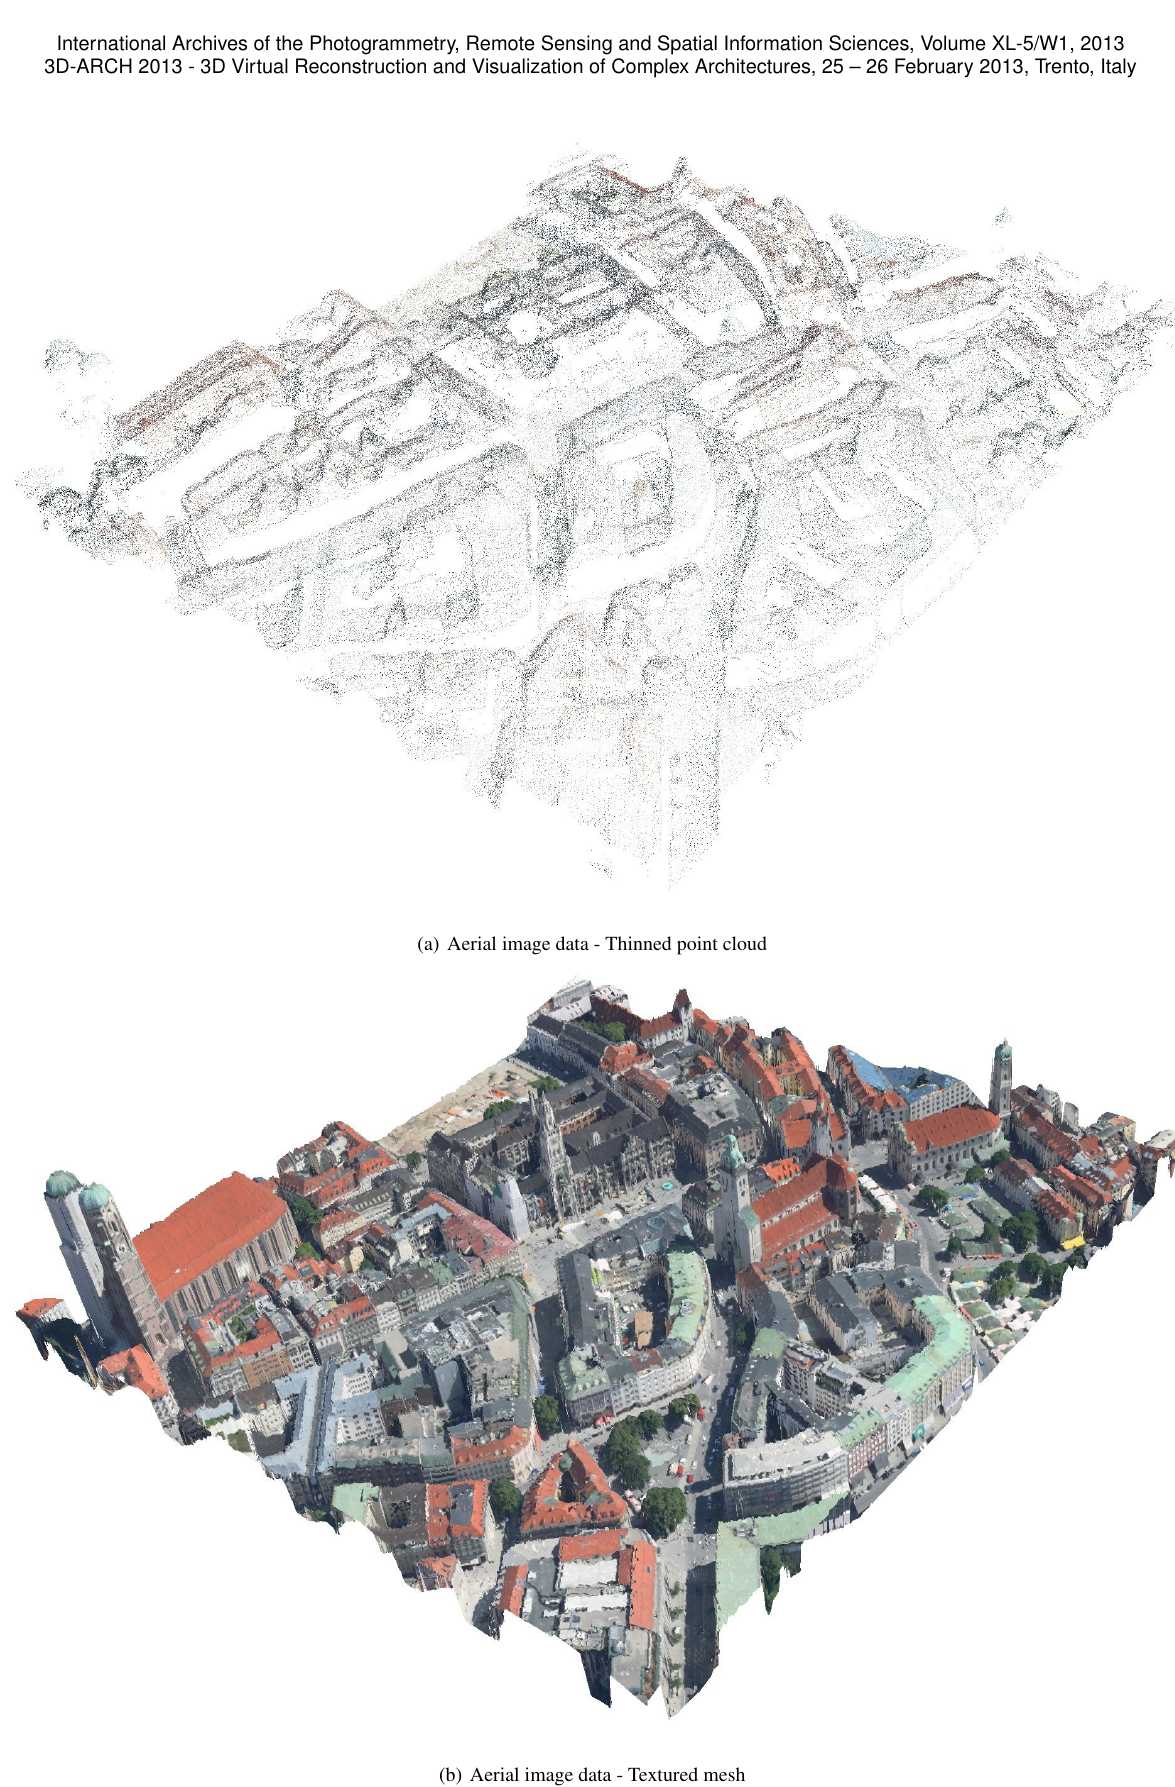
Figure 8: Resulting 3D model of the aerial image